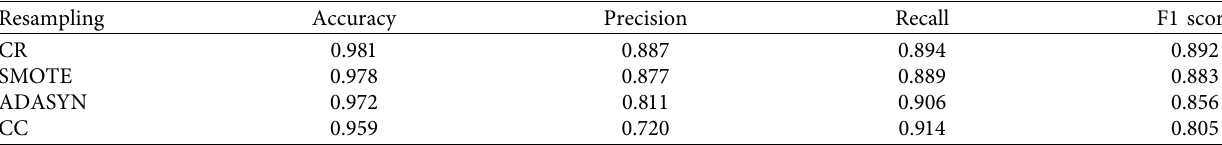
Table 13: Results of best performer ETC using all resampling techniques when data splitting was performed before data resampling.